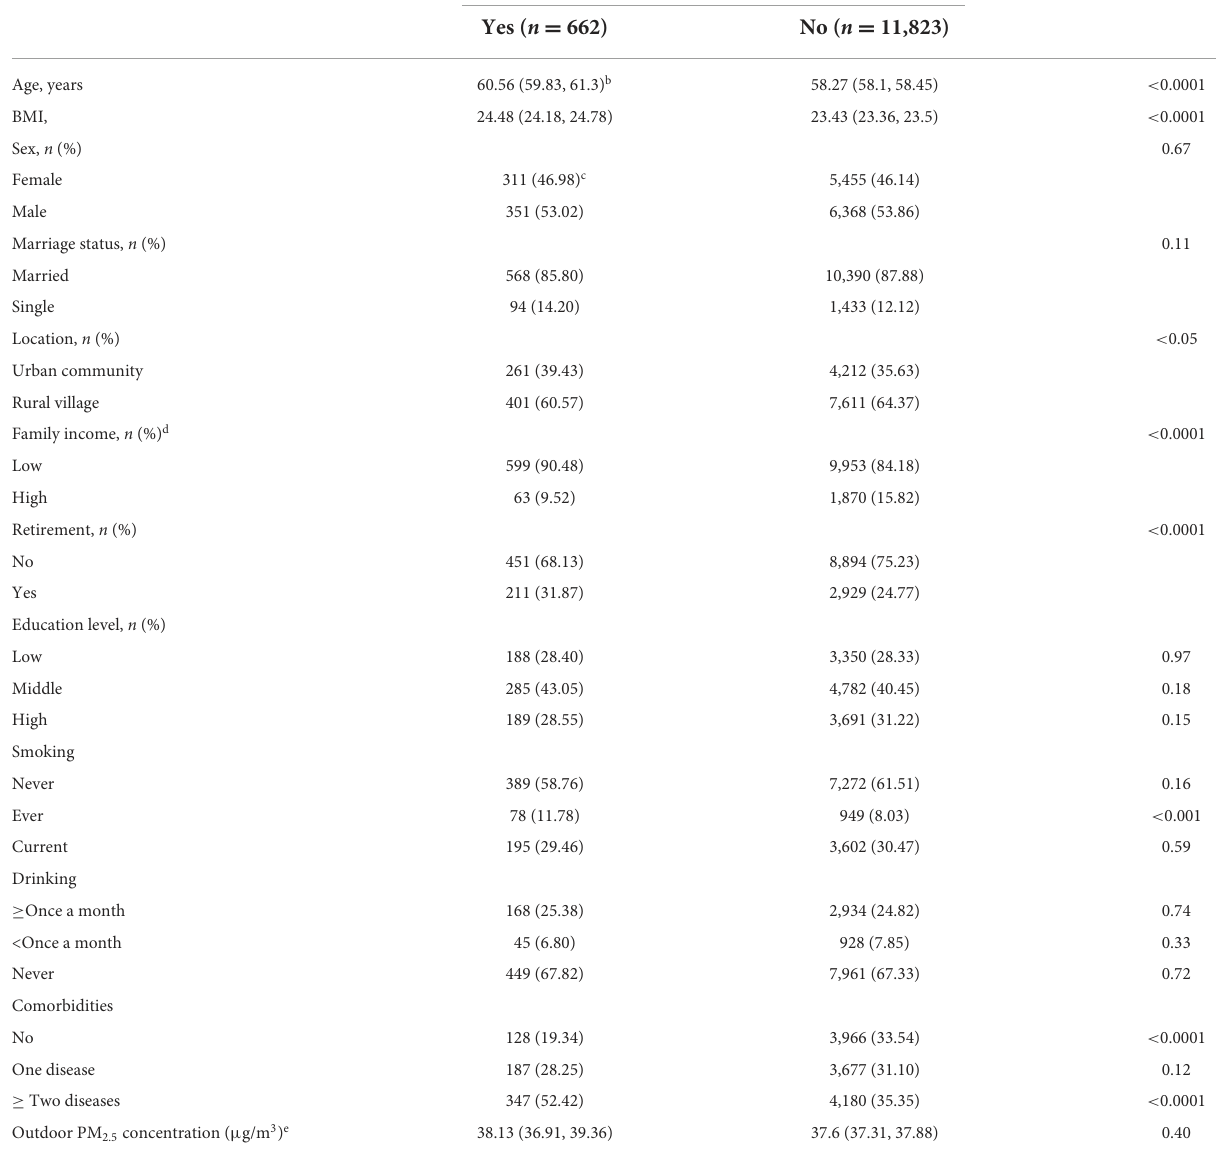
TABLE 1 Baseline characteristics of